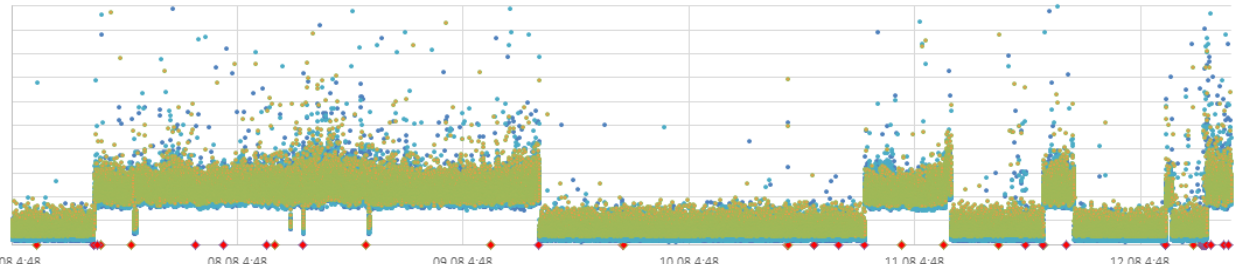
Fig. 15. RTT of all three points of heavily loaded BITE 3G, ms.